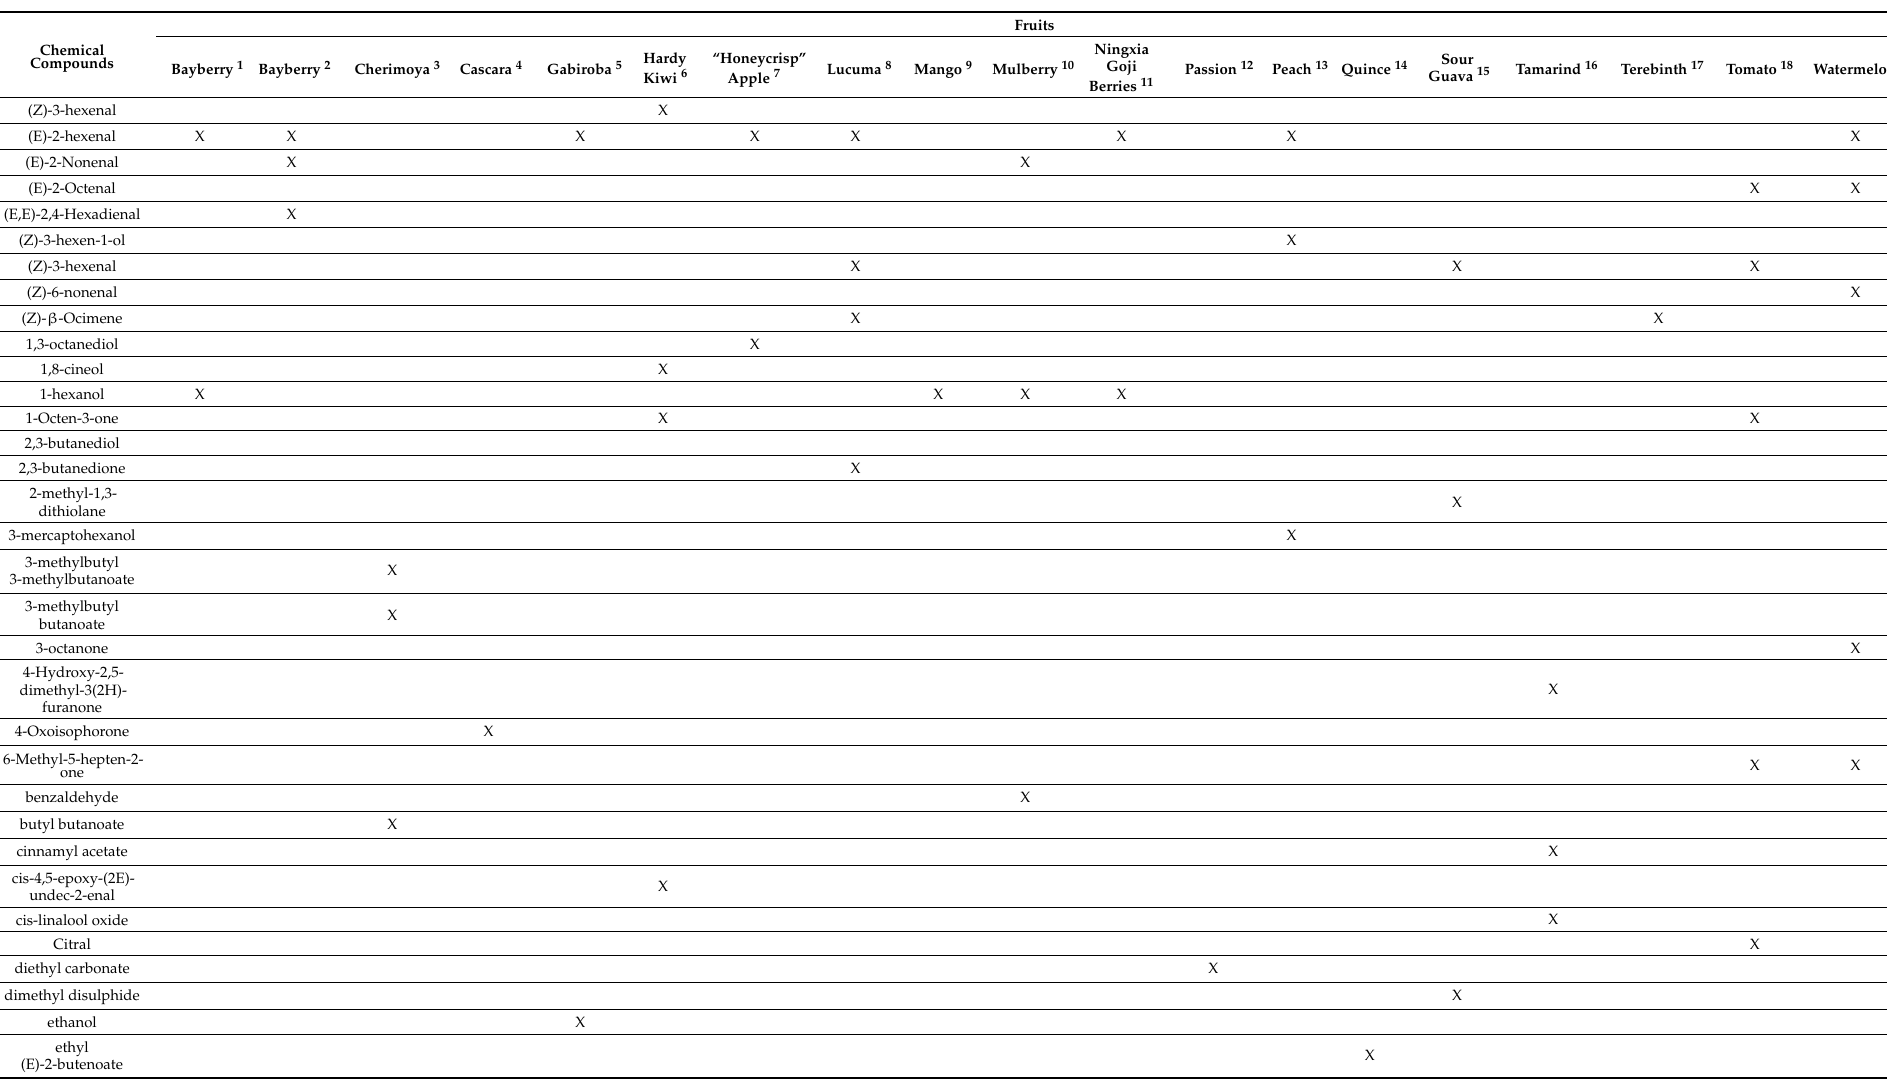
Table 2. The five most important chemical compounds found using gas chromatography–olfactometry of fruit aroma (per column) related by the literature (2015–2021). Chemical